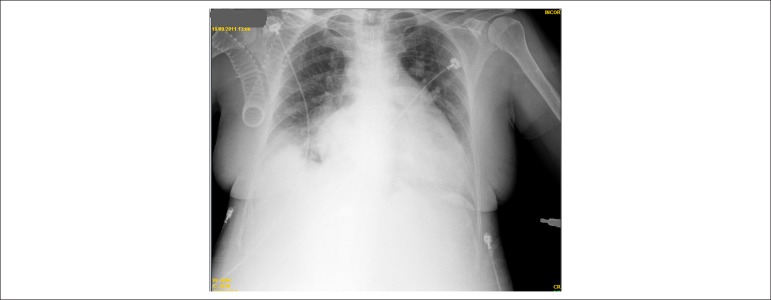
Chest X-ray. Pulmonary congestion, opacification at the right base, and
cardiomegaly with double contour (enlargement of the left atrium), and
abnormal enlargement or bulging at mid-arch of the aorta (enlargement of the
right ventricle).